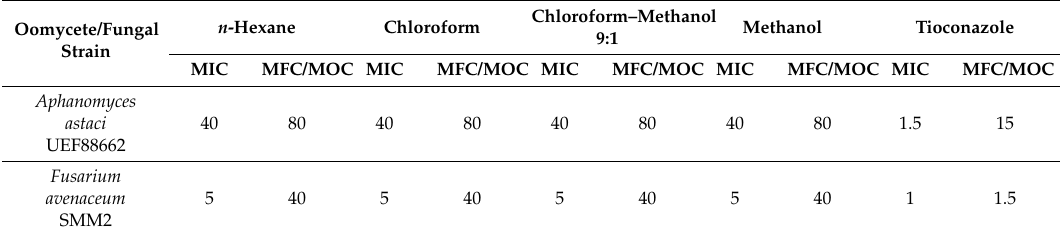
Chloroform–Methanol 9:1